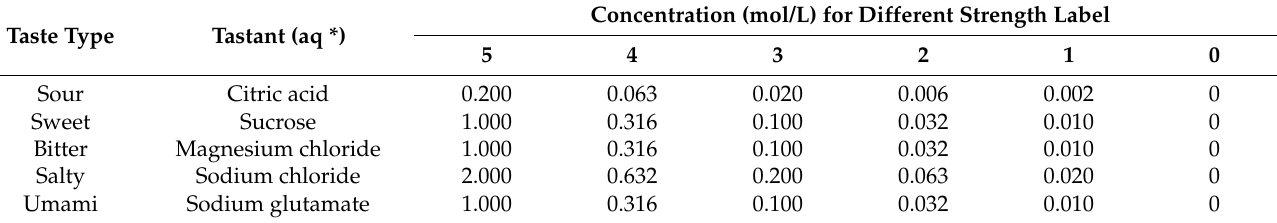
Table 2. The tastants providing different taste types and